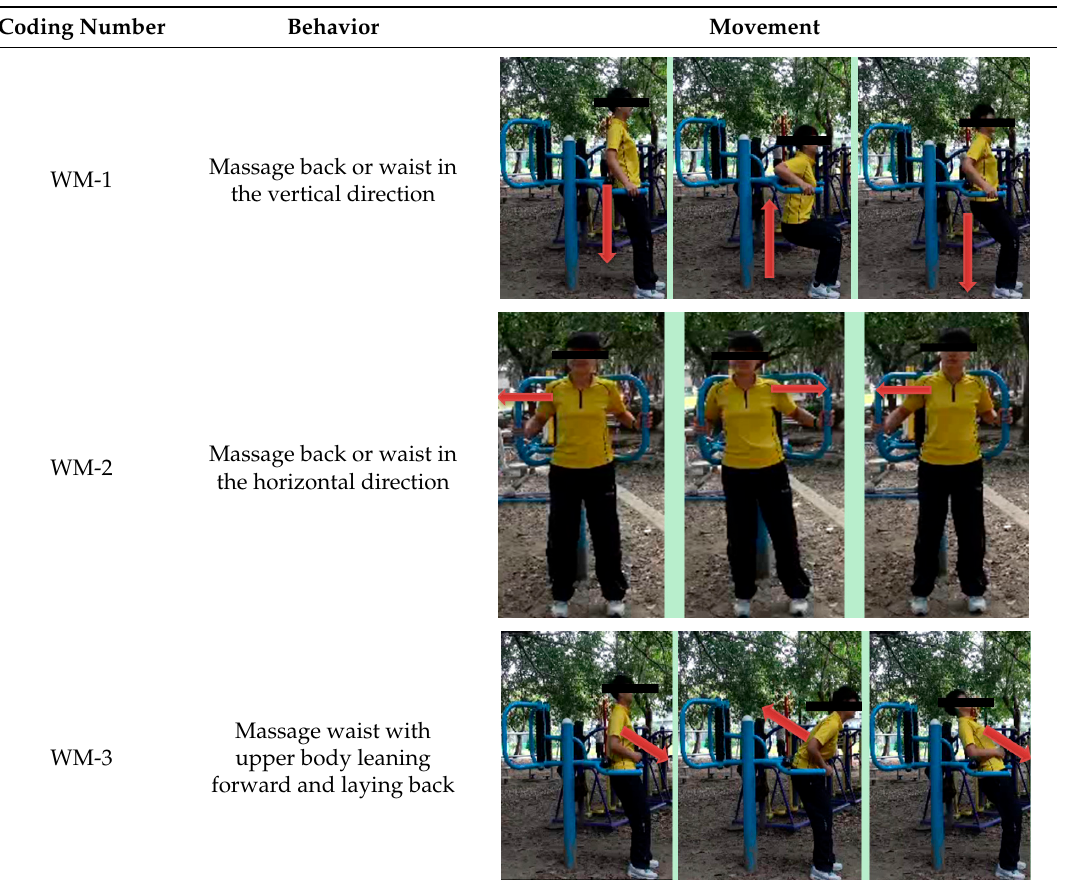
Table A4. Depictions of user behaviors for the waist/back